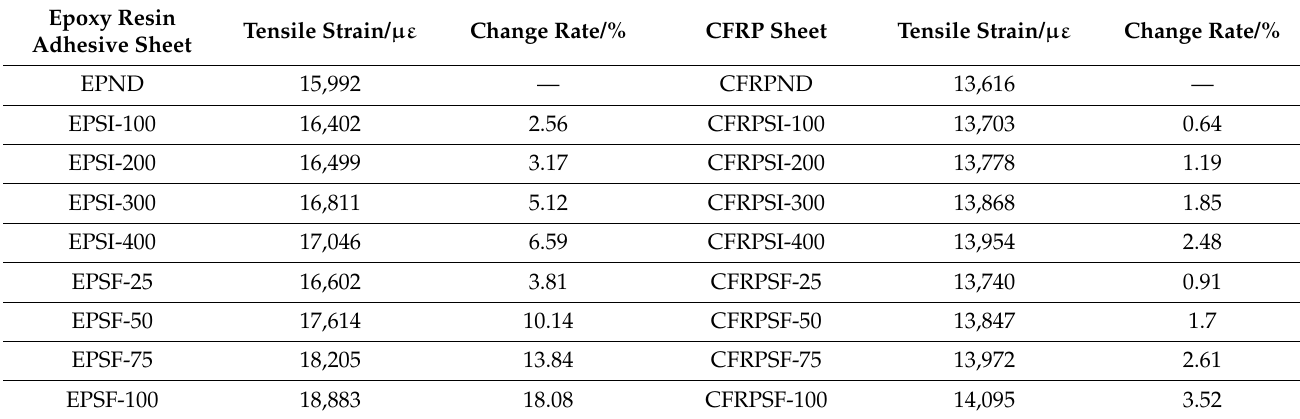
Table 6. Tensile strain of epoxy resin and CFRP sheet.